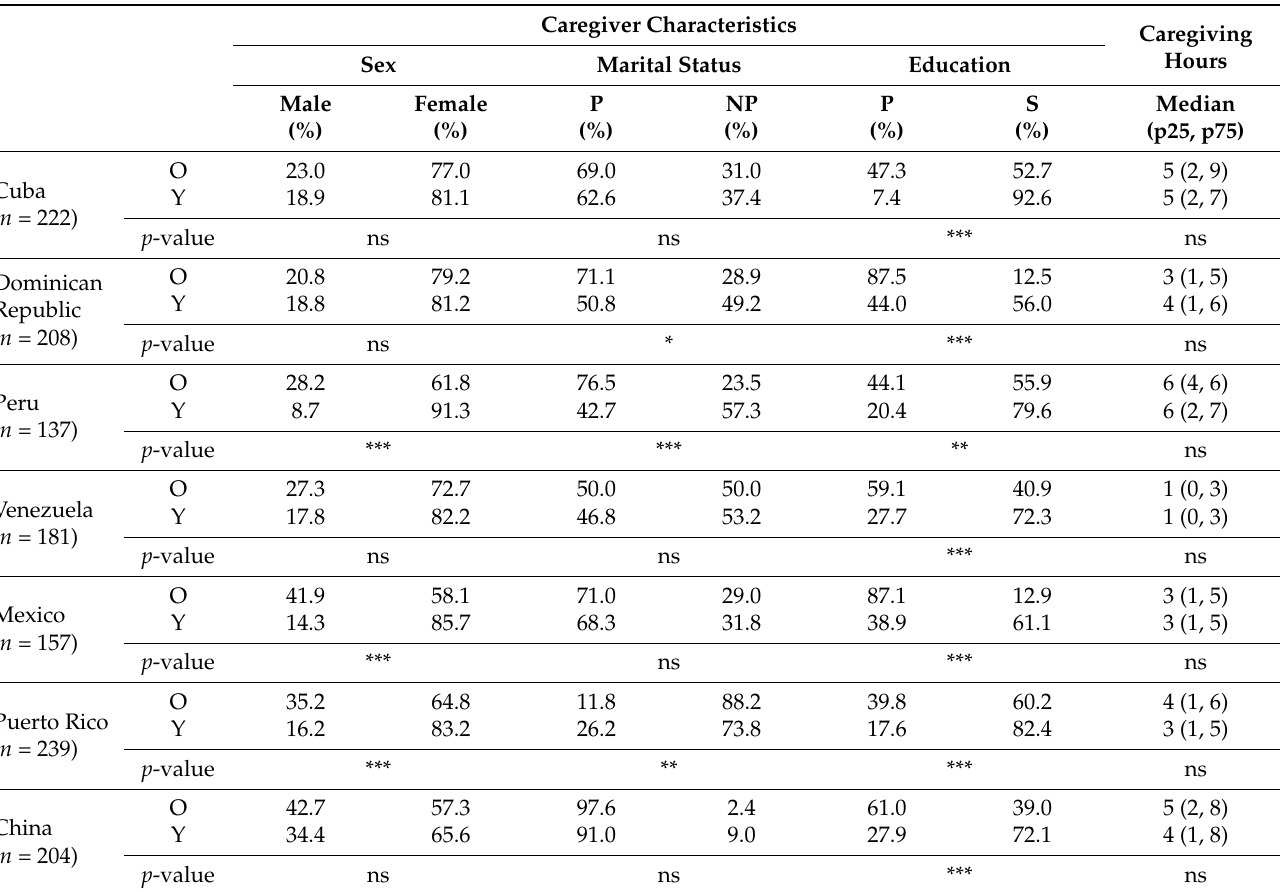
Table 2. Socio-demographic backgrounds and caregiving hours among caregivers in seven countries ( n = 1348